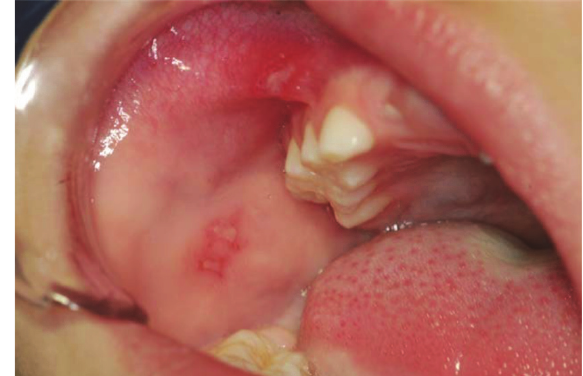
Figure 4: The initial clinical aspect of the ulcerated mucosa. Note the presence of factitious oral ulcers and localized swelling. The lesions were produced by self-biting of buccal vestibule and nail- scratching of gingival